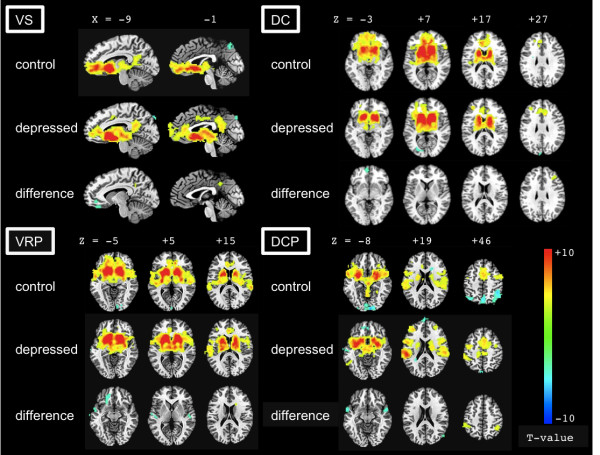
Statistical maps depicting regions of positive and negative functional connectivity with the striatum. Statistical maps depicting regions of positive and negative functional connectivity with the ventral striatum (VS), dorsal caudate (DC), ventral rostral putamen (VRP), and dorsal caudal putamen (DCP) in depressed and control samples, and between-group differences in functional connectivity with these regions (blue = control > depressed; yellow = depressed > control). Voxel-wise p < 0.005, minimum cluster size = 26 voxels.